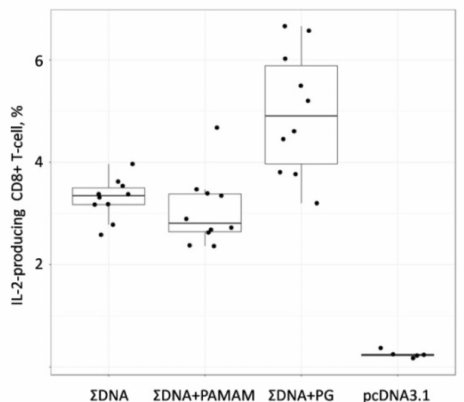
Figure 6. The number of T-cell obtained by IFN- γ -ELISpot assay in immunized BALB / c mice. Mice were immunized with naked plasmids or complex plasmids with cationic polymers three times with two weeks interval. After two weeks after last immunization splenocytes were collected and ELISpot analysis were performed. To analyze Ebola-specific cellular responses splenocytes were stimulated with pool of synthetic peptides, corresponding to CTL- and Th-epitopes of Ebola virus proteins. The reactivity